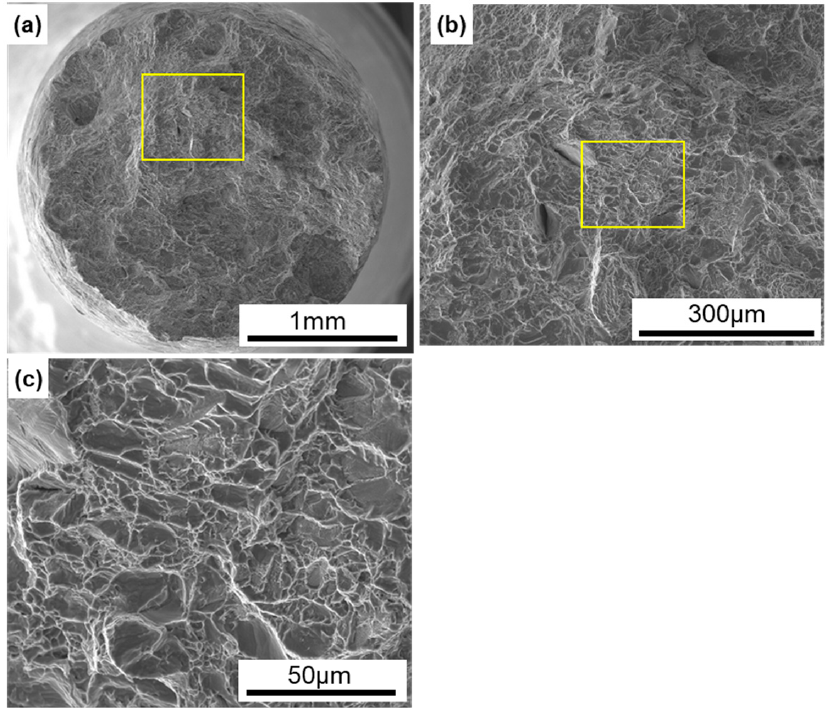
Figure 9. SEM images of fracture surfaces of the tensile-tested TILOP CP Ti G 2 (10-times-sintered); ( b ) magnification of rectangular area in ( a ), and ( c ) magnification of rectangular area in ( b ).